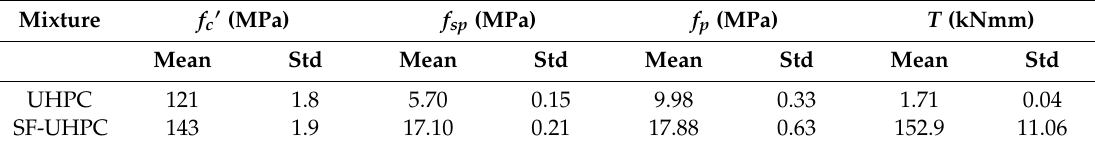
Table 3. Mechanical properties of the